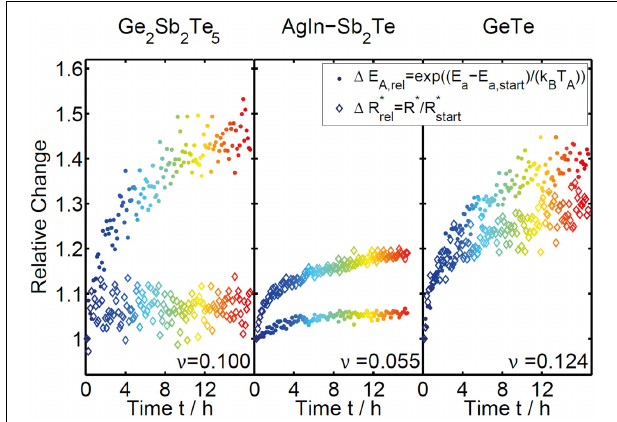
FIGURE 10 | Relative change in resistance due to a change in activation energy and prefactor as a function of drift time for GST, AIST, and GeTe. The relative change due to the change in activation energy is determined by subtracting the initially measured value for E A (determined by the second dip), whereas the relative change due to the prefactor is extracted by a normalization to the value of R ∗ measured in the beginning.